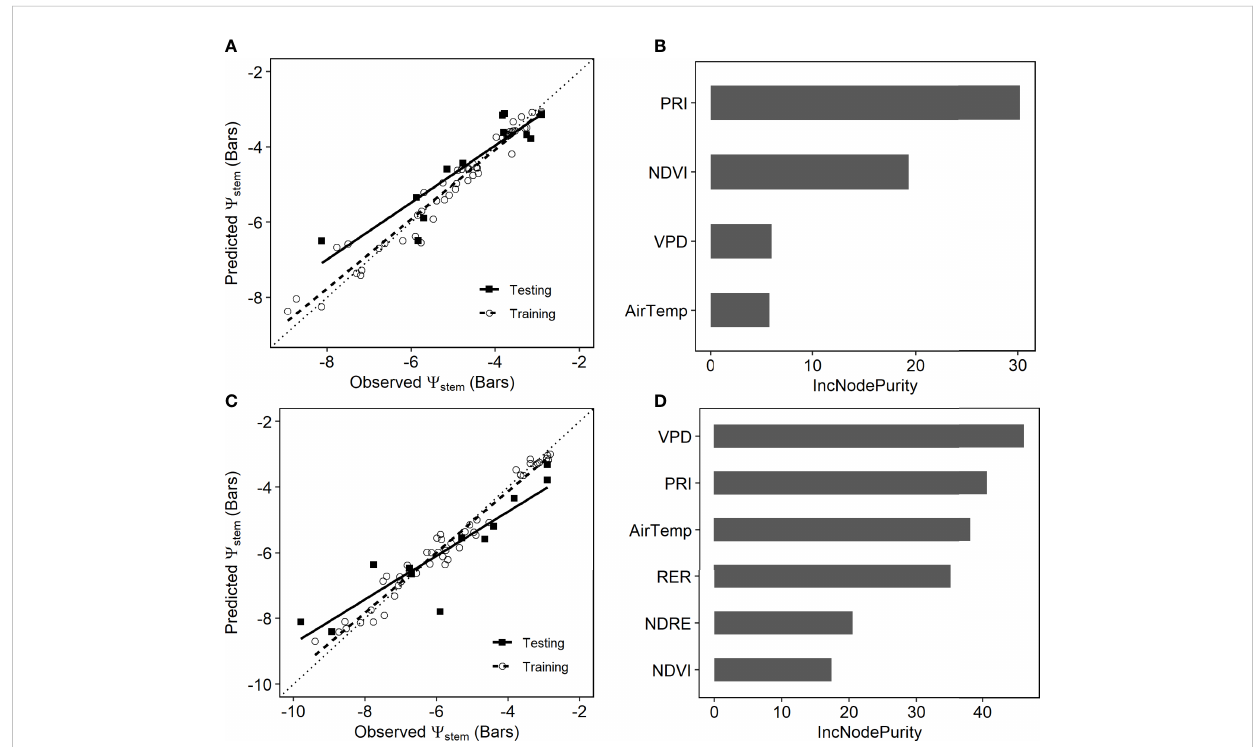
FIGURE 7 (A) Estimated stem water potential ( y stem ) by the random forest model with the proximal sensor observations compared with ground measurements. Ground measurements from multiple dates were randomly split into training (open circles, dashed line) and testing (solid squares, solid line). (B) Variable importance plot of the proximal sensor-based random forest model. (C) Estimated stem water potential ( y stem ) by the unmanned aerial vehicle (UAV)-based random forest model compared with ground measurements. Ground measurements from multiple dates were randomly split into training (open circles, dashed line) and testing (solid squares, solid line). (D) Variable importance plots of the UAV-based random forest model.